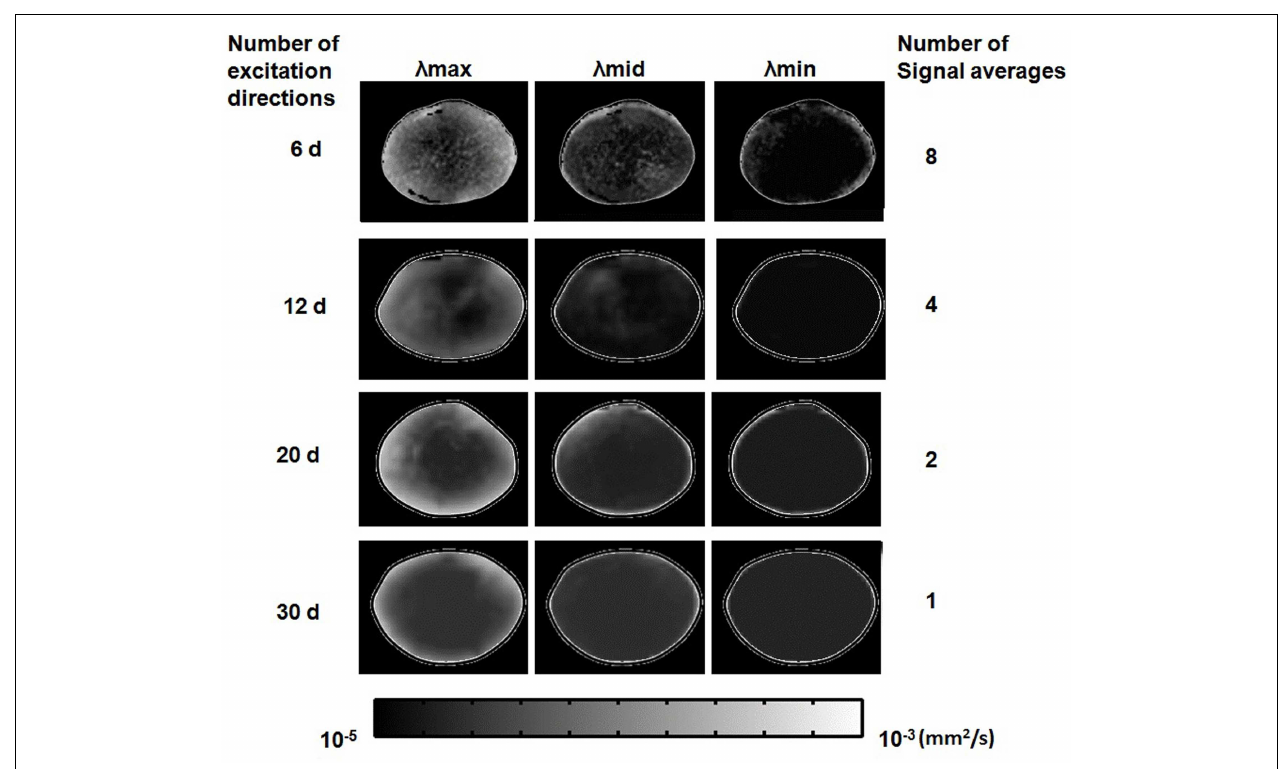
one bovine lens has been scanned using a number of diffusion gradient directions (labeled at left) and a maximum corresponding number of signal averages (labeled at right) possible within the lens culture time limit (seeText). The eigenvalue maps are shown masked (manually) from the surround for ease of comparison.The very bright lens edge seen on some of the panels is due to an edge effect and